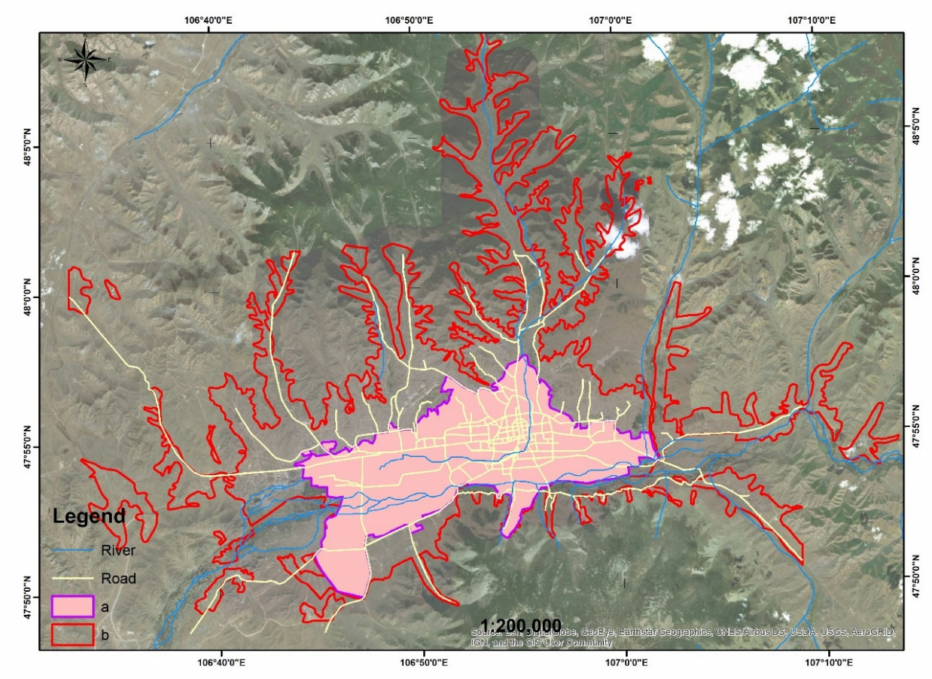
Figure 8. Map using the compact city concept: ( a ) After the implementation of the compact city concept; ( b ) urban sprawl by 2020.